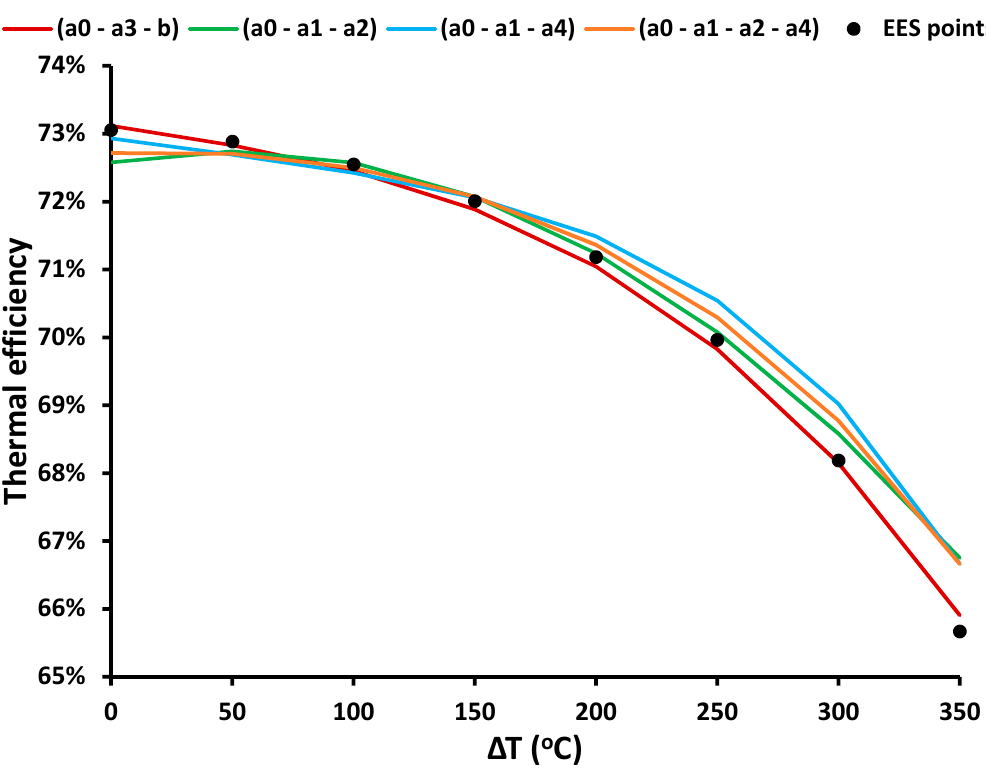
Figure 7. Comparison of the suggested model ( a 0 , a 3 , b ) with other usual models for G b = 1000 W/m 2 .